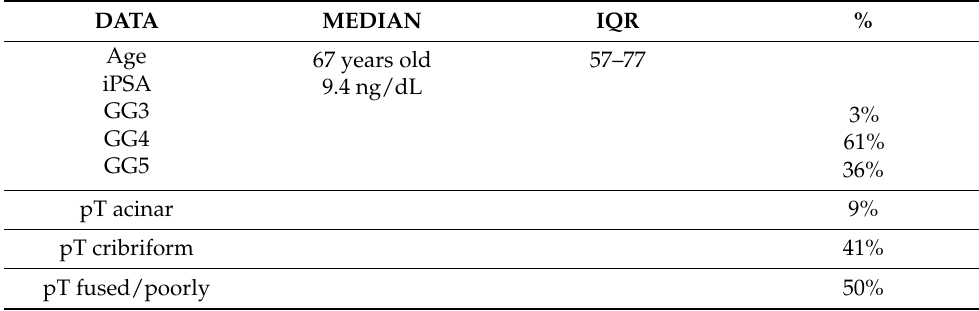
Table 1. Population’s characteristics.